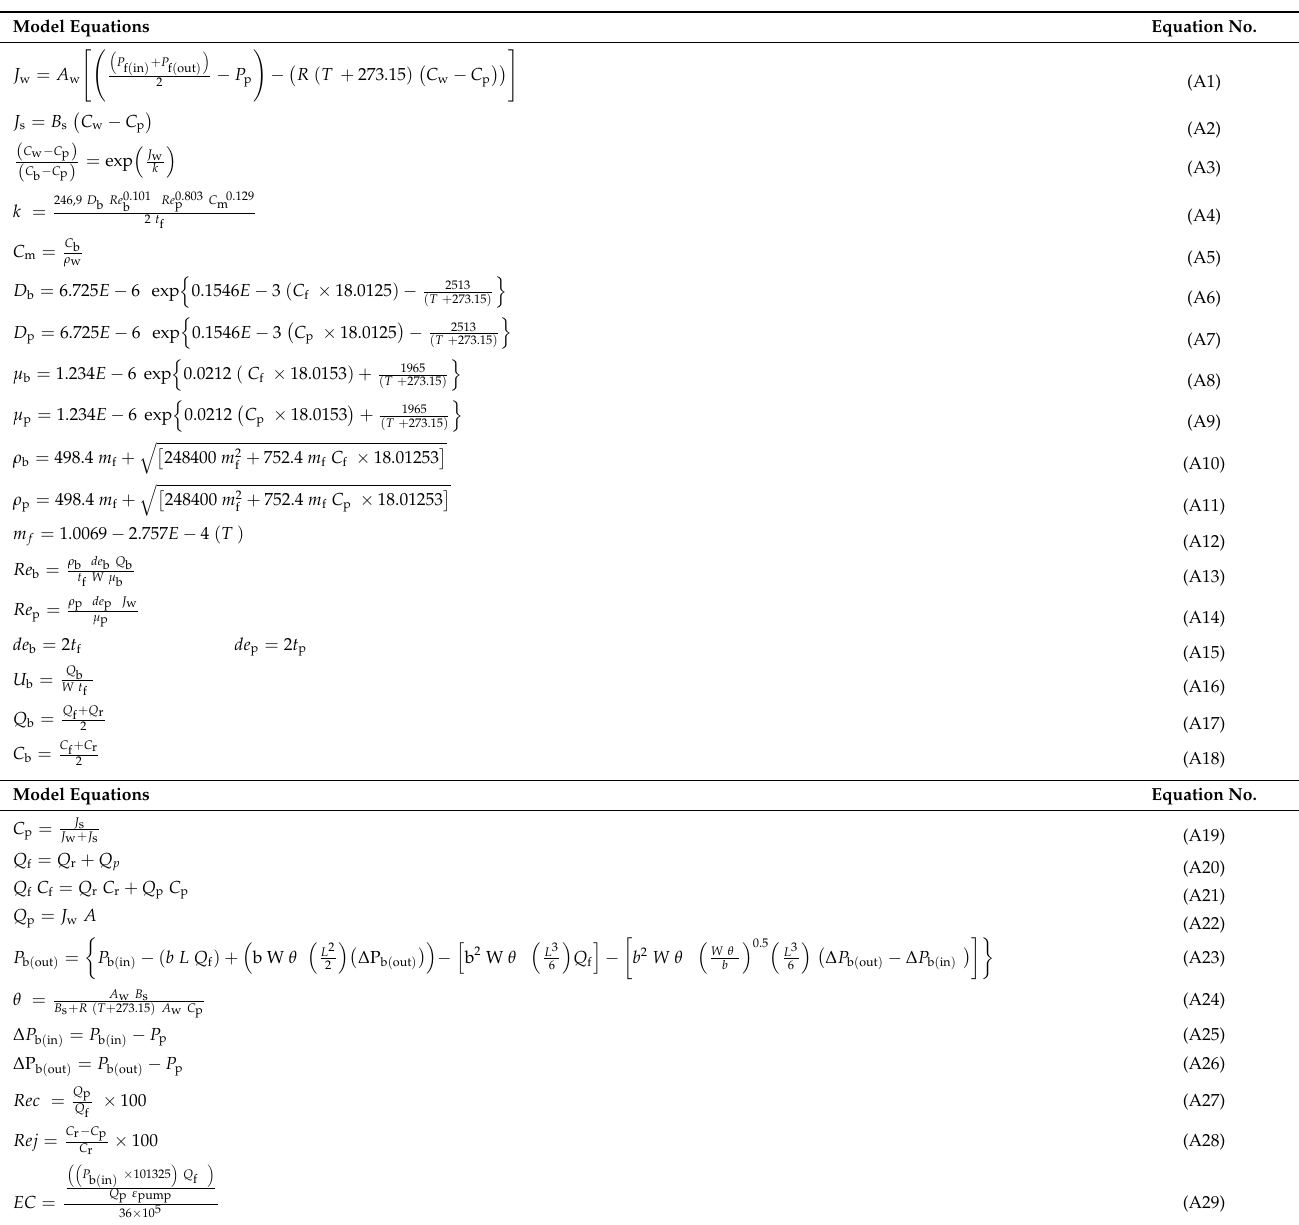
Table A1. Modelling of a spiral wound membrane module of RO